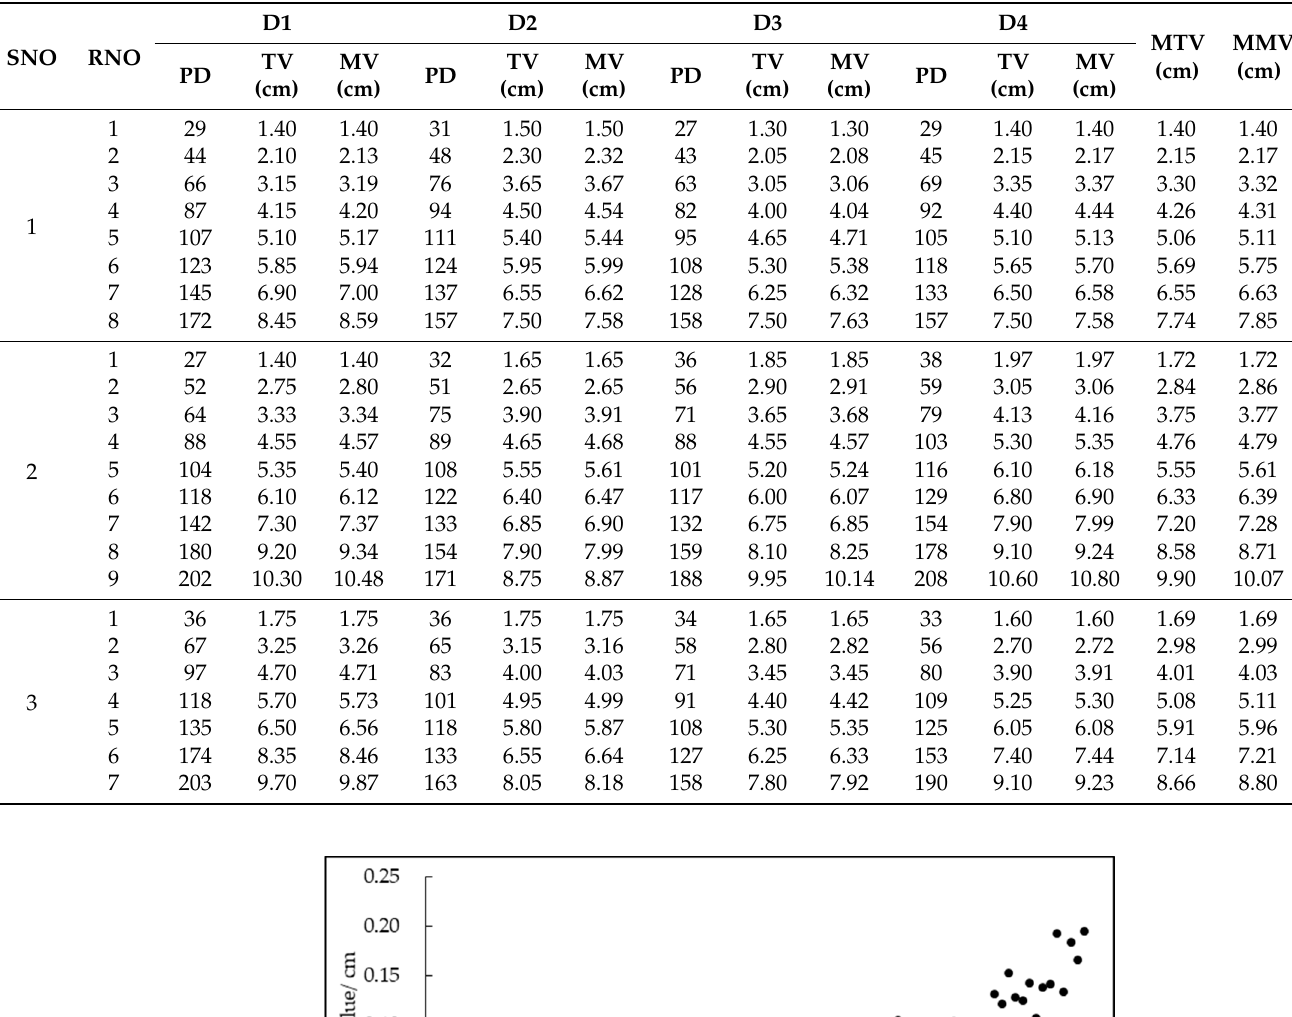
Table 3. The true value and the measured value of the ring radius data. SNO is the sample number of the imitation stem analysis disk. RNO is the number of the growth ring (the number starts at the heart of the pith). D1, D2, D3, and D4 represent four measurement directions. PD is the pixel distance from this ring to the heart of the pith. TV is the true value of the ring radius. MV is the measured value of the ring radius. MTV is the mean of the true values. MMV is the mean of the measured value.